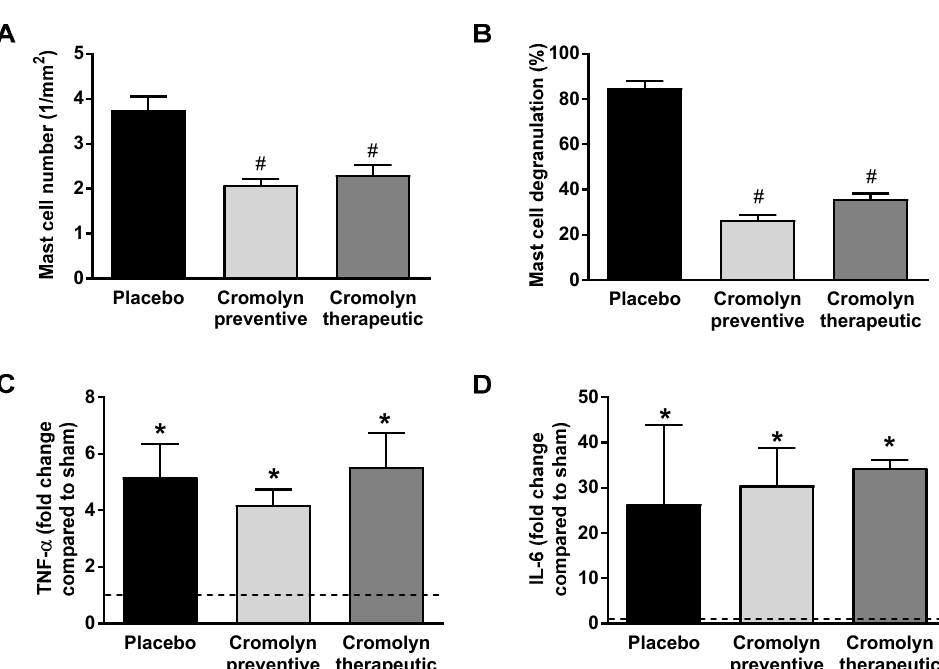
Figure 7. E ff ects of cromolyn on inflammatory responses in the pressure-overloaded right ventricles of C57Bl / 6J mice following pulmonary artery banding (PAB). ( A , B ) Bar graphs summarizing quantification of mast cell density and activity in the right ventricles of PAB mice. ( C , D ) Quantification of qPCR data in the right ventricles of MC +/+ and Kit W / Kit W-v mice following PAB shown as fold change in mRNA expression of tumor necrosis factor α (Tnf- α ) and interleukin-6 (IL-6). Values are means ± SEM. qPCR results are presented as fold induction of target gene transcripts compared to sham. One-way ANOVA with Dunnett’s post-hoc multiple-comparisons test was used in ( A , B ); one-way ANOVA with Tukey’s post-hoc multiple-comparisons test was used in ( C , D ). # p < 0.05 versus placebo-treated PAB mice, * p < 0.05 versus sham mice, n = 5 mice per group for mast cell density and activity quantification and n = 4 mice per group for qPCR analysis.